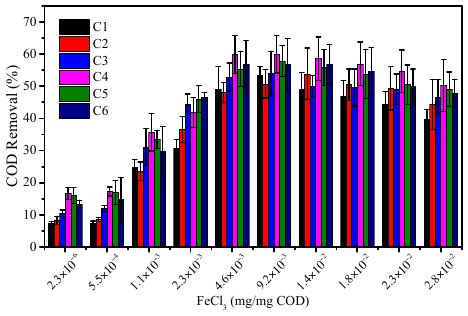
Figure 1. Effect of coagulation on COD removal efficiencies.